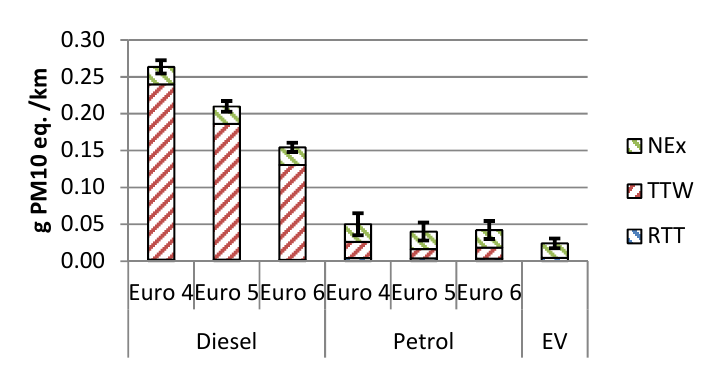
Figure 9. Particulate Matter impact contribution.